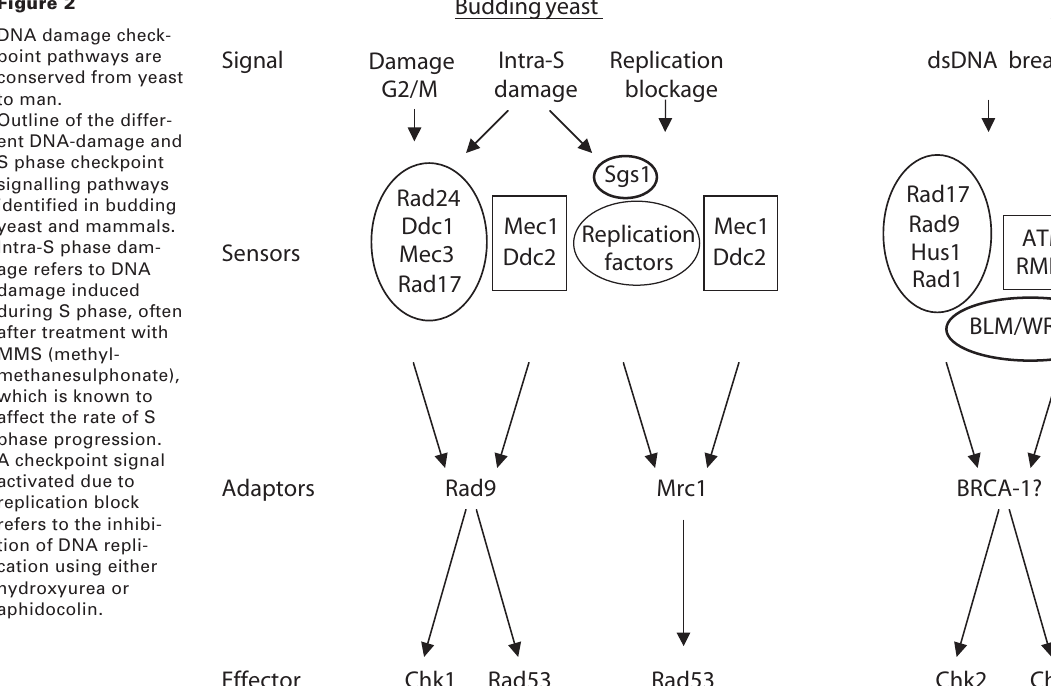
DNA damage check- point pathways are conserved from yeast to man. Outline of the differ- ent DNA-damage and S phase checkpoint signalling pathways identified in budding yeast and mammals. Intra-S phase dam- age refers to DNA damage induced during S phase, often after treatment with MMS (methyl- methanesulphonate), which is known to affect the rate of S phase progression. A checkpoint signal activated due to replication block refers to the inhibi- tion of DNA repli- cation using either hydroxyurea or